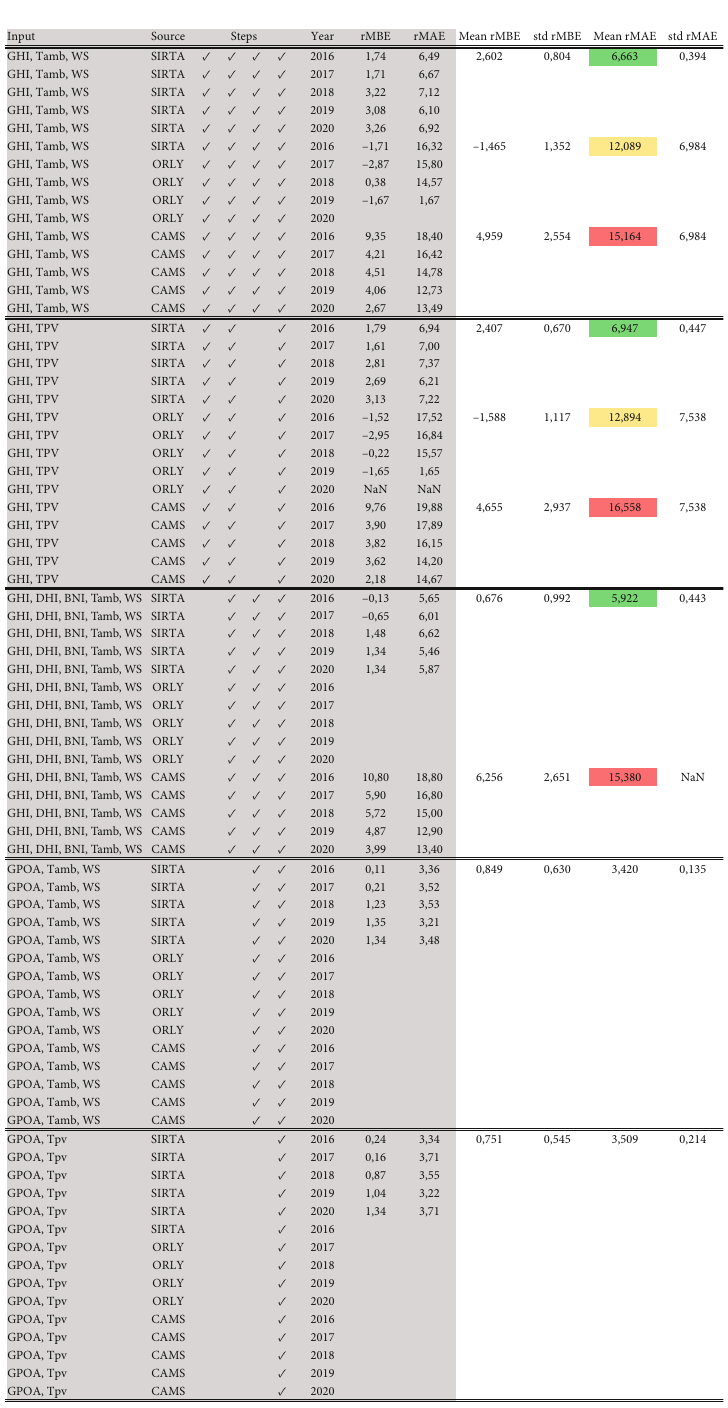
Figure 10: Computed rMBE and rMAE for SIRTA in situ ground-based measurements, ORLY weather station ground-based measurements, and CAMS satellites images, for each modeling step. Colors are performance indicators (from green for the best to red for the